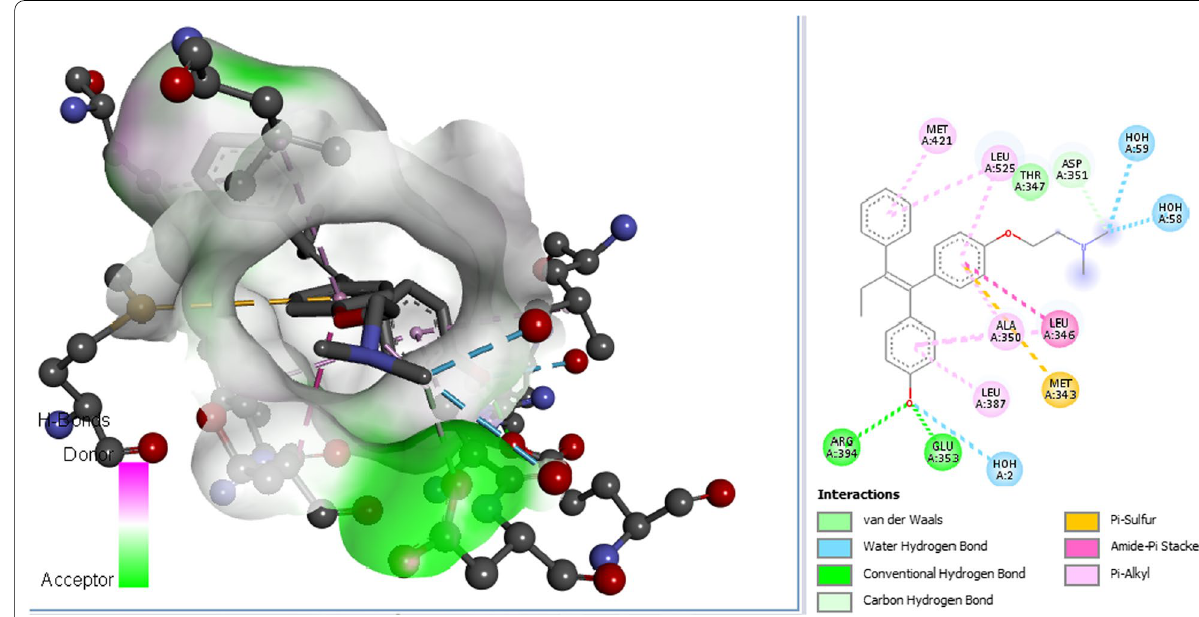
Fig. 16 3D and 2D original interaction modes of Tamoxifen with the active site of the 3ERT